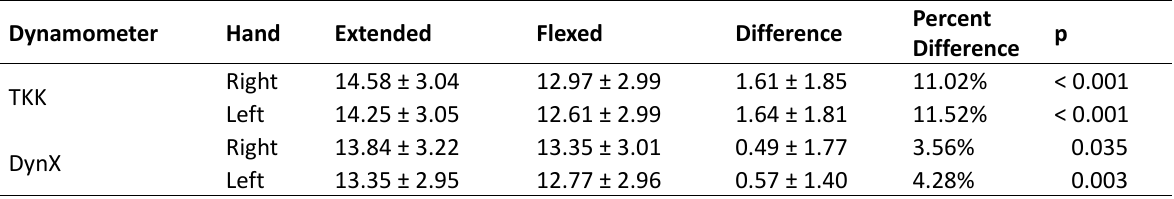
Table 1. Handgrip strength according to the type of dynamometer and hand and elbow position (at full extension and flexed at 90°) in children aged 6 to 11 years (n = 60), Mean ± SD